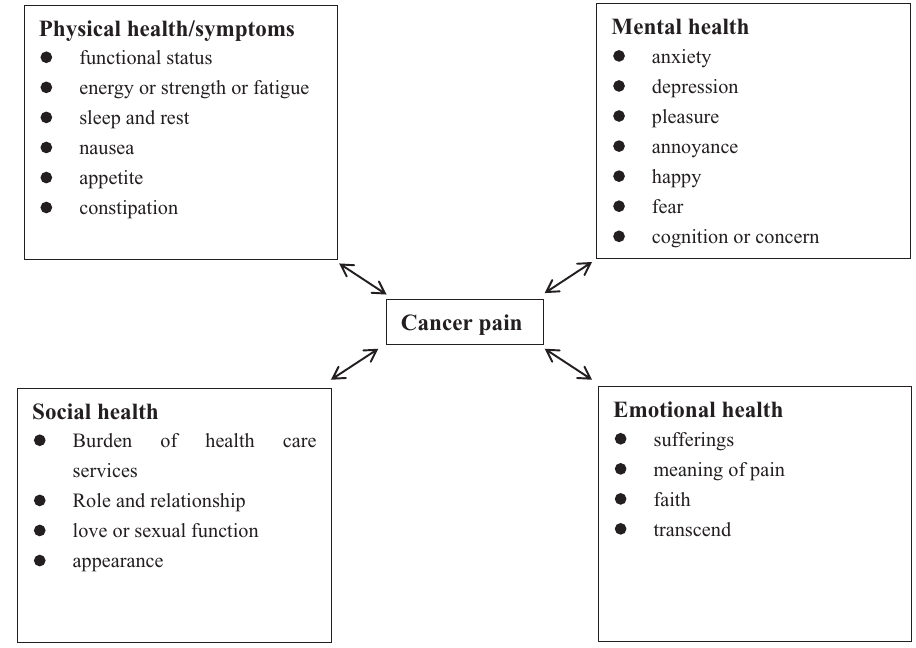
Figure 1. The influence of cancer pain on the patient’s